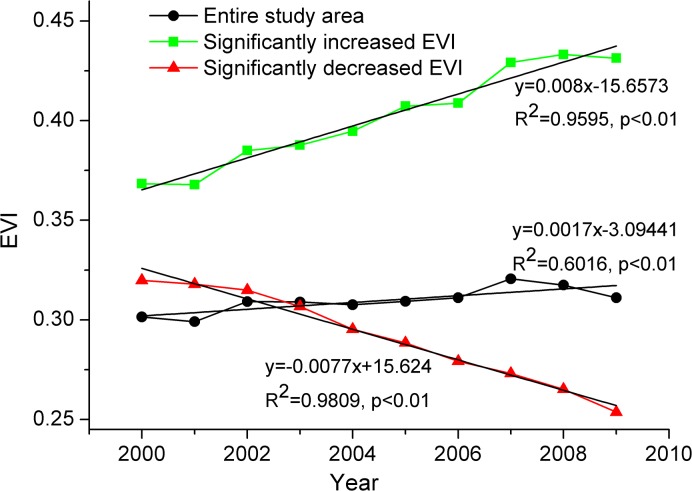
Time series of averaged EVI in southern China.Black is for the entire study area, green is for the regions with significantly increased EVI, and red is for regions with significantly decreased EVI.